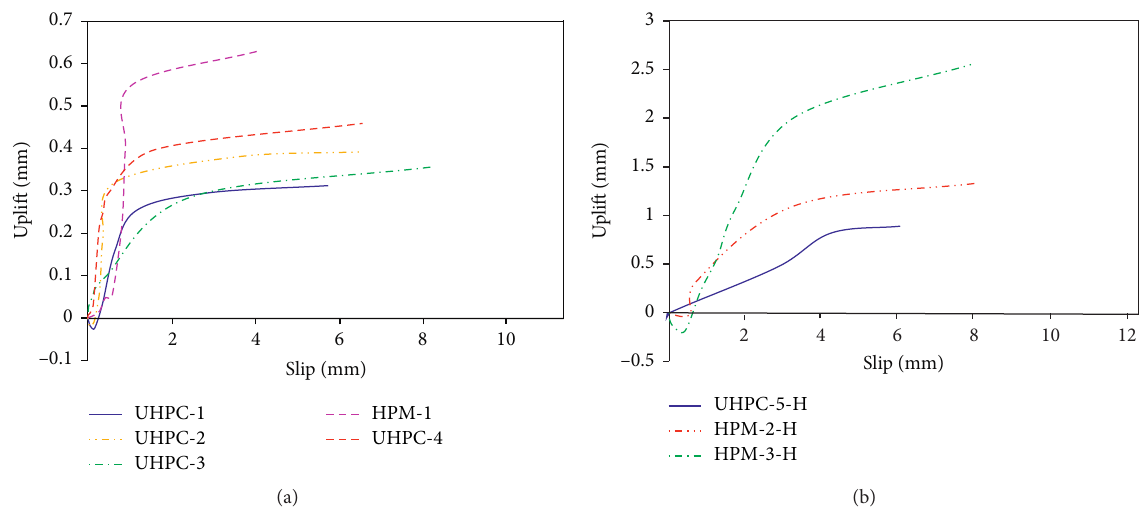
Figure 15: Slip-uplift curves: (a) specimens without holes in steel rib; (b) specimens with holes in steel